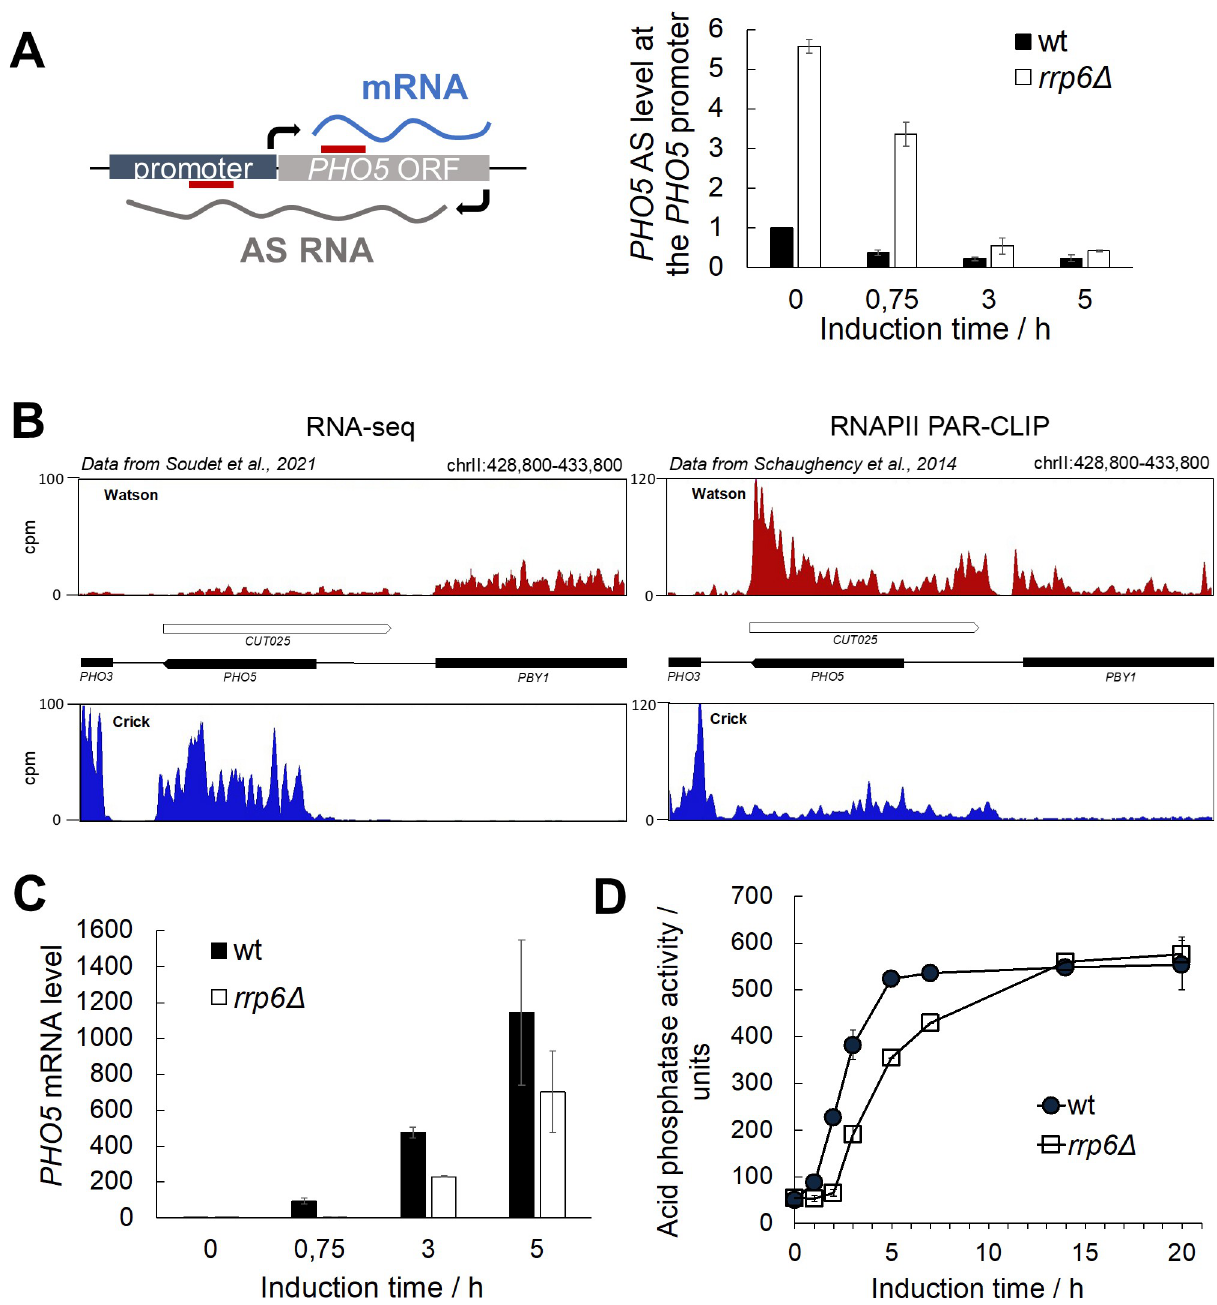
Fig 1. Kinetics of PHO5 gene expression are inversely correlated with level of the corresponding antisense transcript. (A) Scheme showing transcription of an antisense (AS) RNA at the PHO5 gene locus with thick straight red lines denoting the the regions used for qPCR (left) and AS RNA levels at the PHO5 promoter region in wild-type BMA41 (wt) and corresponding rrp6 Δ mutant cells upon induction through phosphate starvation, monitored by strand-specific reverse transcription quantitative PCR (RT-qPCR) (right). RT-qPCR values were normalized to PMA1 RNA and expressed relative to transcript abundance in wild-type cells under repressive conditions (0 h of induction), which was set to 1. (B) The left panel shows RNA-seq signal from an Nrd1-AA strain in the absence of rapamycin (wild-type equivalent) at the PHO5 locus. The right panel represents RNAPII PAR-CLIP signal or nascent transcription signal in the same conditions. Data were retrieved from [46] and [47], respectively. (C) Levels of PHO5 mRNA in wild-type BMA41 (wt) and corresponding rrp6 Δ mutant cells upon induction through phosphate starvation. RT-qPCR values were normalized to PMA1 RNA and expressed relative to transcript abundance in wild-type cells at repressive conditions (0 h of induction), which was set to 1. (D) Same as (C), but acid phosphatase induction kinetics were monitored by measuring acid phosphatase activity with whole cells. Reported values represent the means and standard deviations of three independent experiments (n =